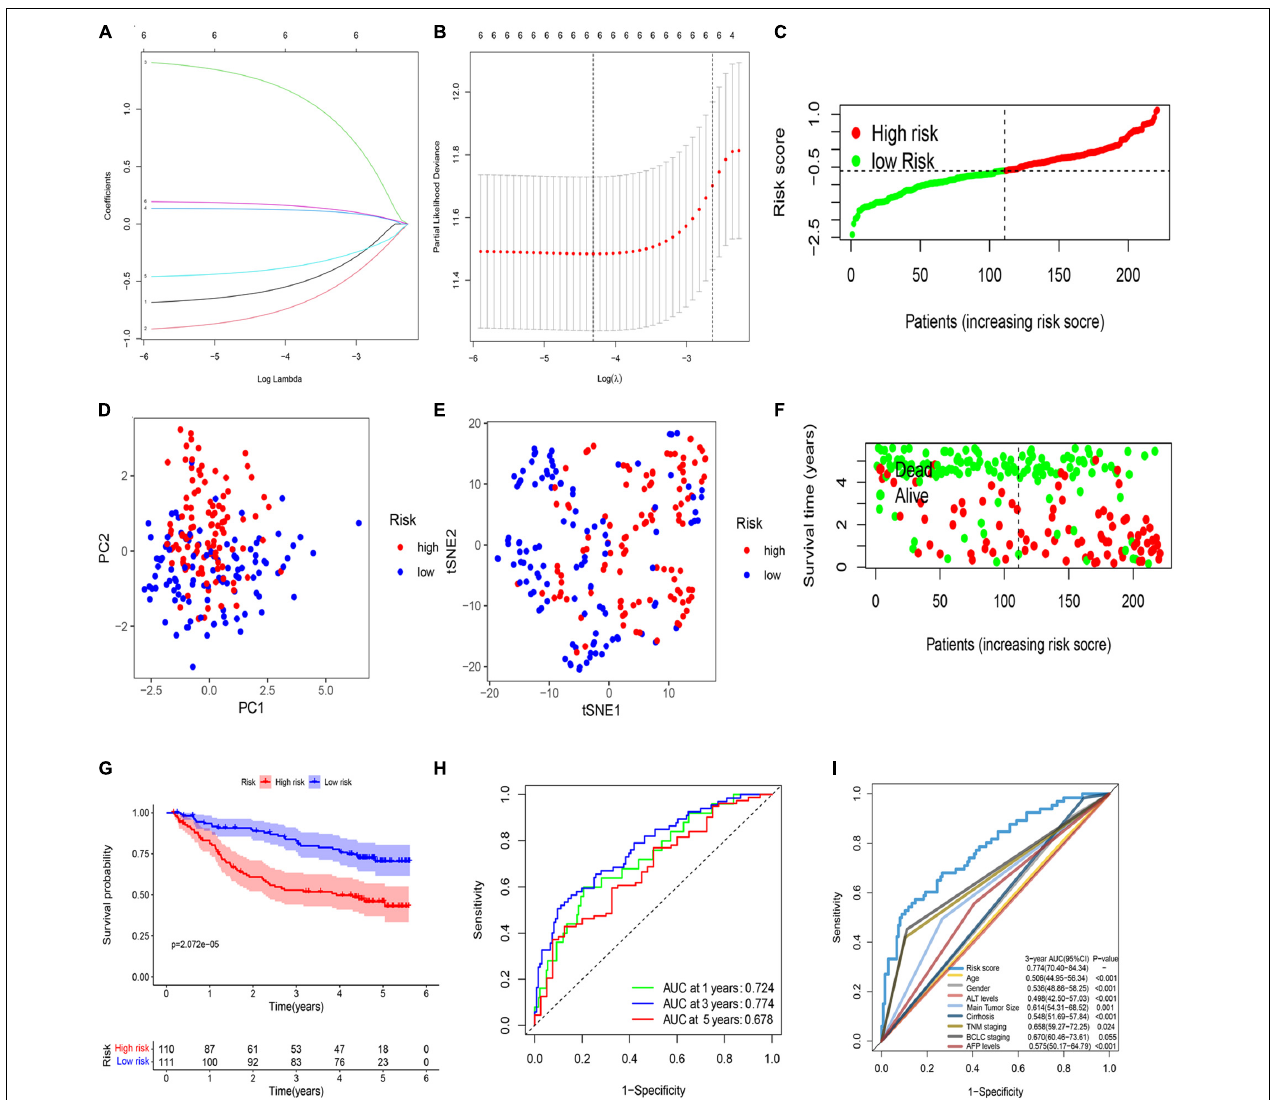
FIGURE 2 | Construction of a prognostic PRG model in the GEO cohort. (A) Validation for LASSO regression via minimum criteria. (B) LASSO coefficients of pyroptosis-related genes. (C) Risk score analysis of the six-PRG profile in the training cohort. (D) PCA plot based on the risk score. (E) t-SNE analysis of the training cohort. (F) The survival status analysis based on risk score in the training cohort. (G) The Kaplan–Meier curve of the low- and high-risk groups based on the six-pyroptosis-related gene profile. (H) Time-dependent ROC analysis for the 1-, 3-, and 5-year OS of the six-PRG profile in the training cohort. (I) Time-dependent receiver operating characteristic (ROC) analysis for 3-year OS of six-pyroptosis-related genes was compared to age, gender, ALT levels, main tumor size, cirrhosis, TNM stage, BCLC stage, and AFP levels in the training